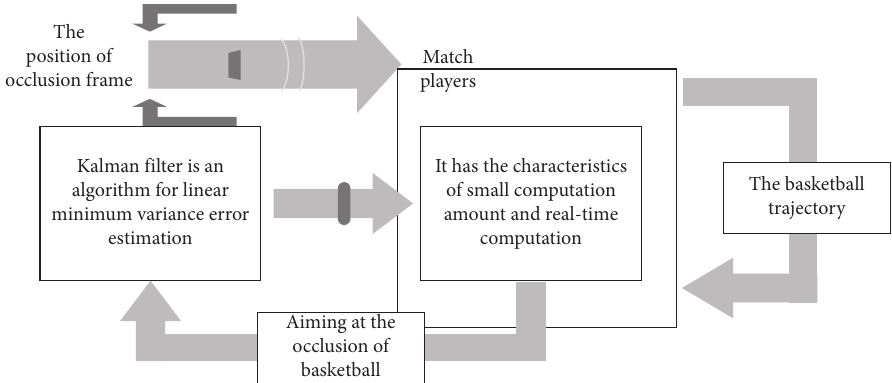
Figure 1: The structure of this